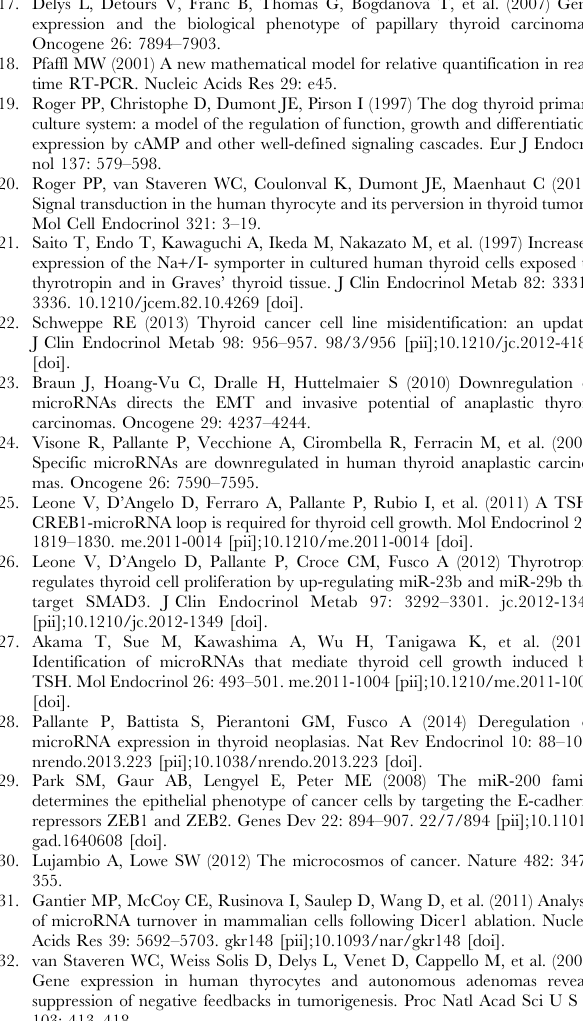
Figure S1 Measurement by qRT-PCR of NIS mRNA serum treatment compared to non-treated cells con-